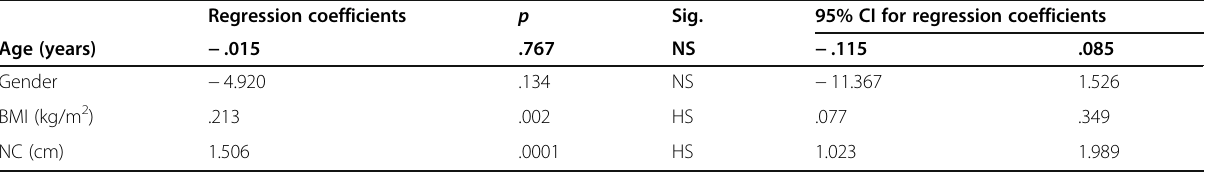
Table 6 Linear regression analysis to determine the factors affecting the severity of OSA Regression